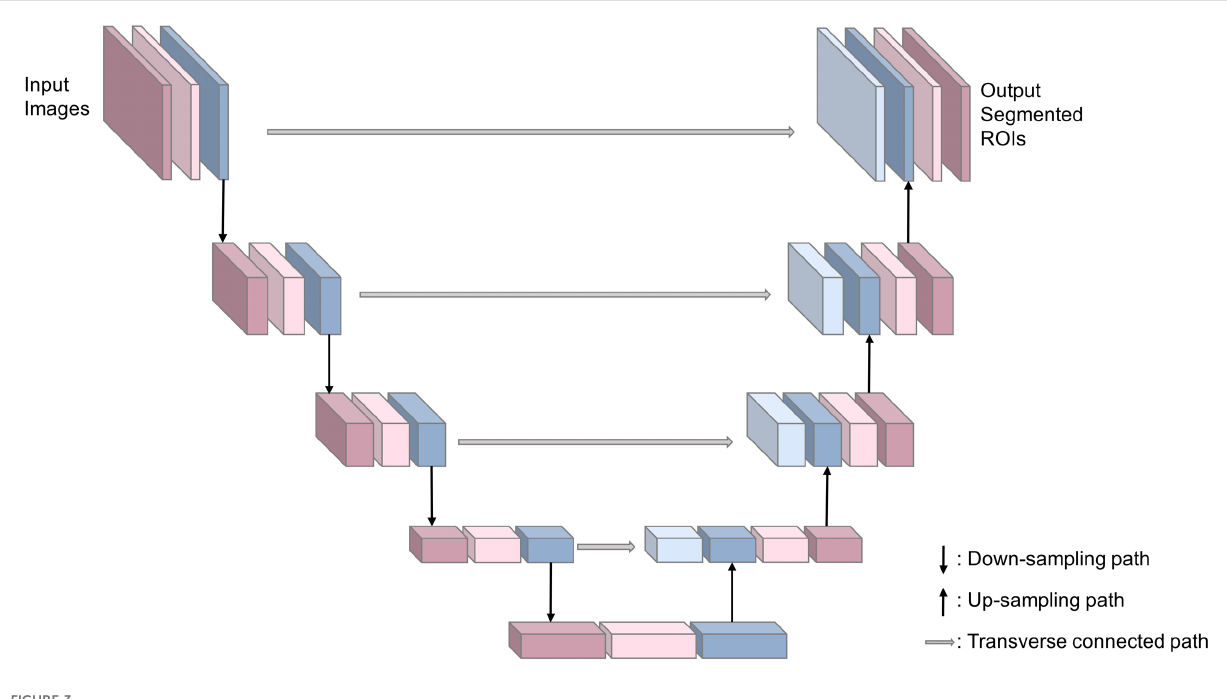
FIGURE 3 Structure of